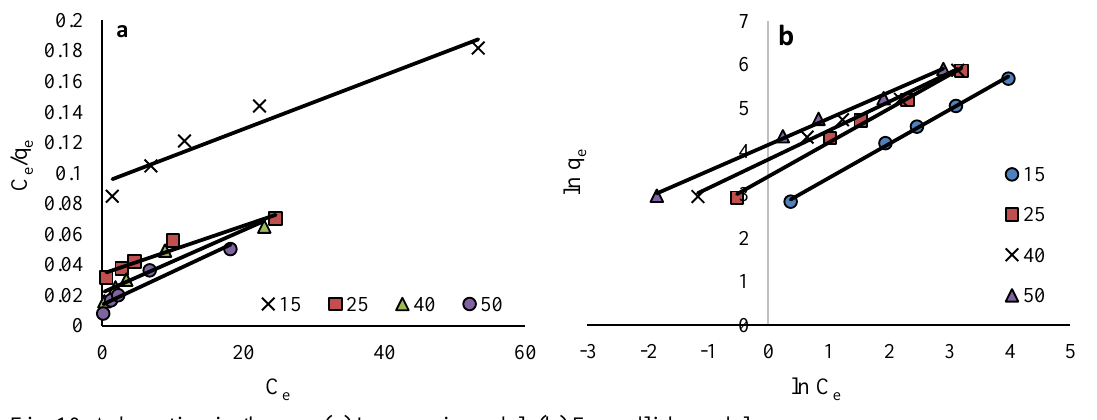
Fig. 10. Adsorption isotherms: (a) Langmuir model, (b) Freundlich model Table 3. Variables of adsorption isotherms of Direct Blue 15 on EDTA and chitosan-modified MWCNT Isotherm model T (°C) Frundlich